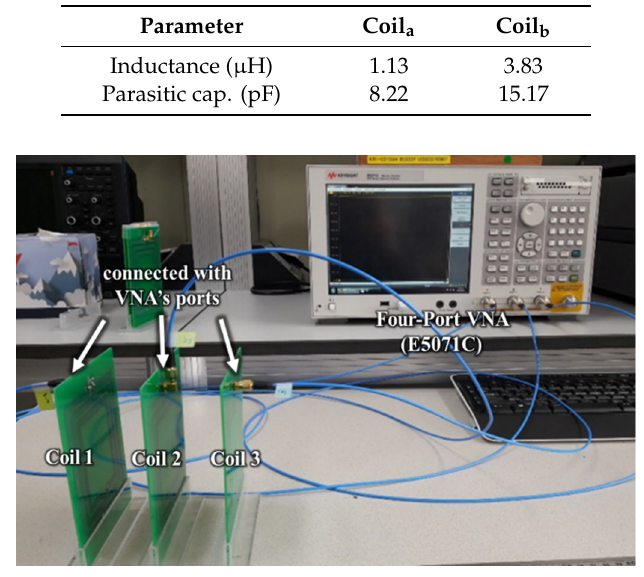
Figure 7. The experimental setup with a four-port vector network analyzer (VNA). Table 1. The parameter for designed coils.